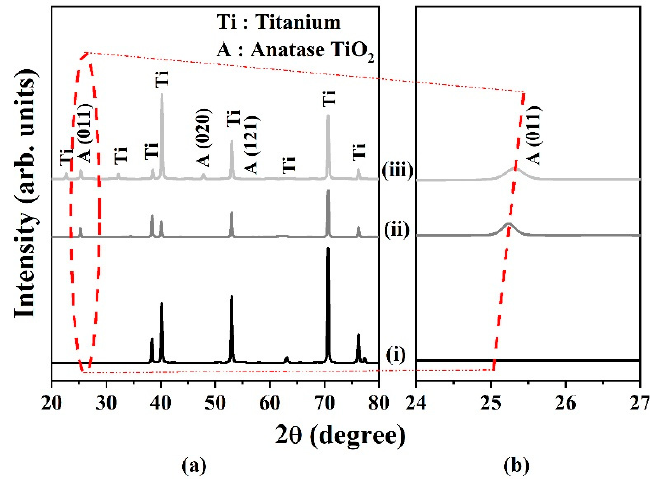
Figure 7. ( a ) XRD patterns for (i) as-anodized TNTs (20 V) and TNTs anodized in (ii) air and (iii) nitrogen. ( b ) Enlarged XRD patterns for anatase (011) peak. Annealing was conducted at 450 °C for 3 h.